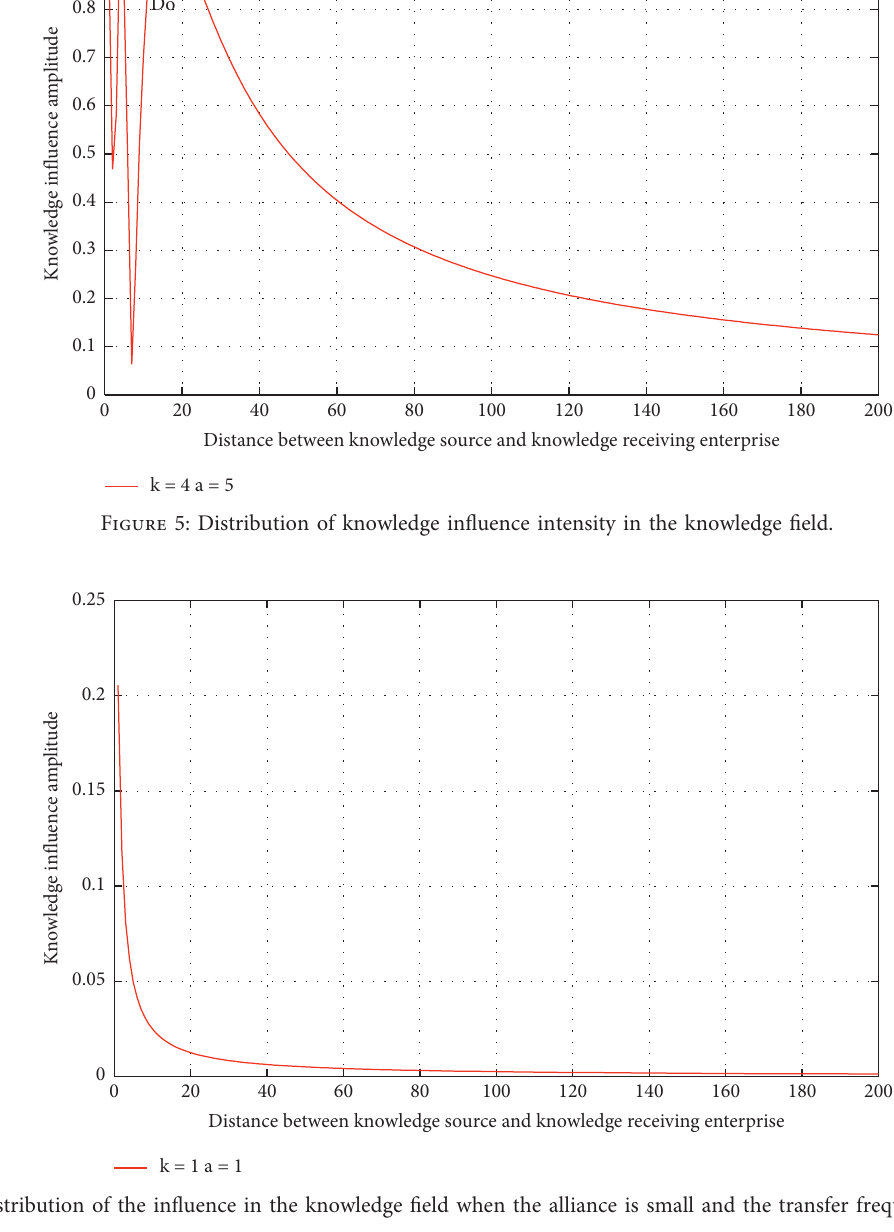
Figure 6: Distribution of the influence in the knowledge field when the alliance is small and the transfer frequency is very low.